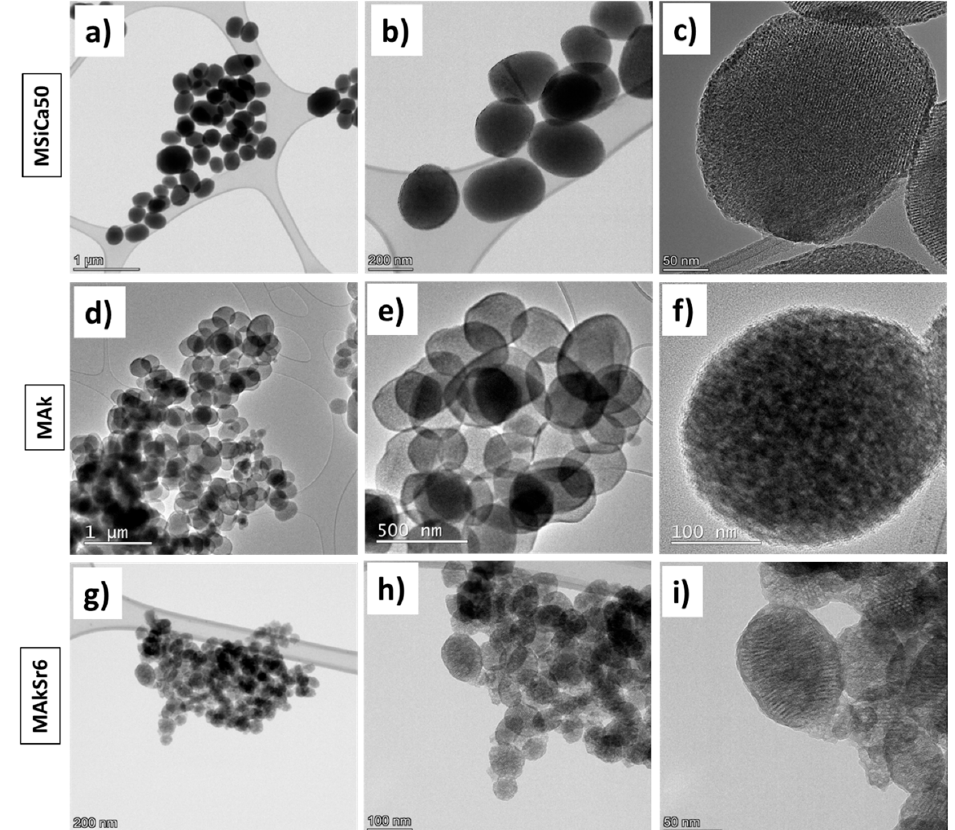
Figure 6. Indicative TEM images: ( a , b ) particle size and morphology of the MSiCa50 nanoparticles; ( c ) identification of the hexagonal mesoporous channels in the MSiCa50 nanoparticles (NPs); ( d , e ) particle size and morphology of the MAk nanoparticles; ( f ) identification of hexagonal mesoporous structure in MAk NPs; ( g , h ) particle size and morphology of the MAkSr6 nanoparticles; ( i ) identification of hexagonal mesoporous structure in MAkSr6 NPs.